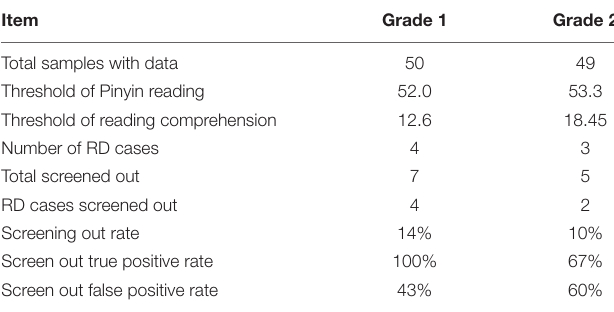
TABLE 2 | Pinyin mock screening test